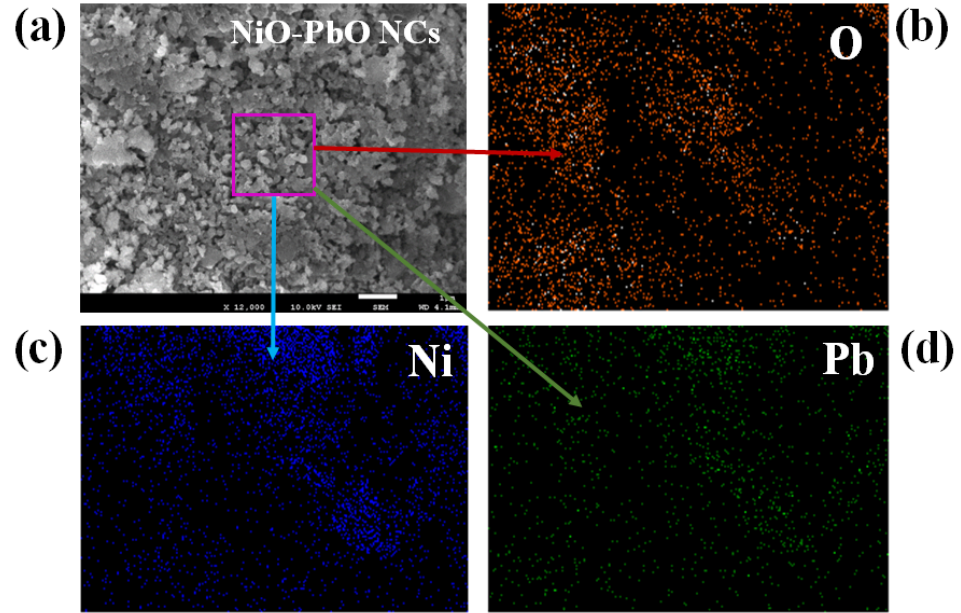
Figure 2. EDS mapping of PbO-doped NiO nanocomposites. ( a ) SEM image of PbO-doped NiO NCs, ( b ) Oxygen mapping, ( c ) Nickel mapping, and ( d ) Lead mapping.